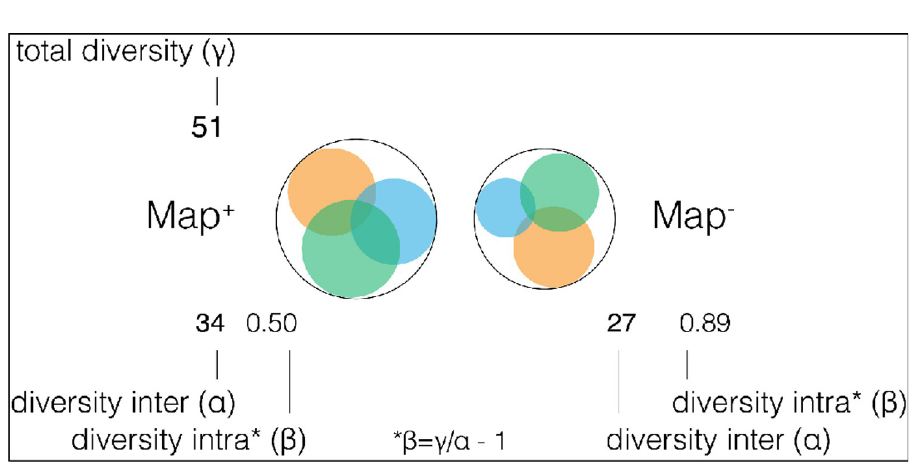
Fig 5. Diversity indices between MAP+ and MAP- samples. Alpha (richness), gamma (total diversity) and beta (overlap; [gamma/alpha]-1) were included.